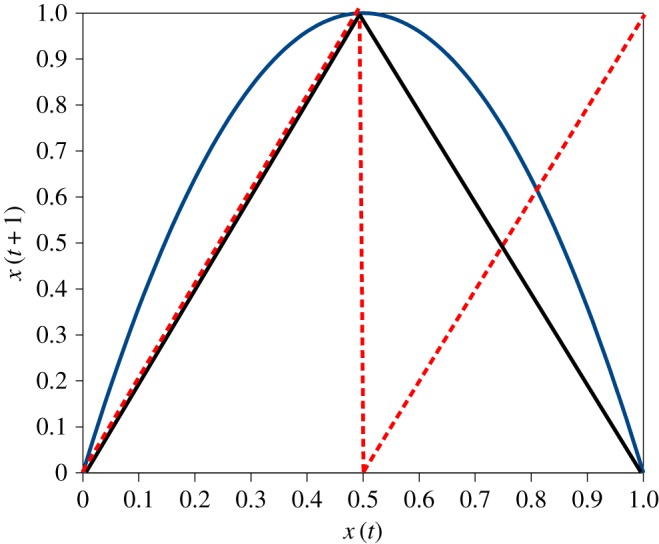
The logistic map, r = 4, is the parabola. The tent map, solid black, appears as a straightened version of the logistic, and the Bernoulli map as a broken tent map, in dashed red. We retain the graph wall to create an image of a box for a particle to bounce around in, according to the map rules.